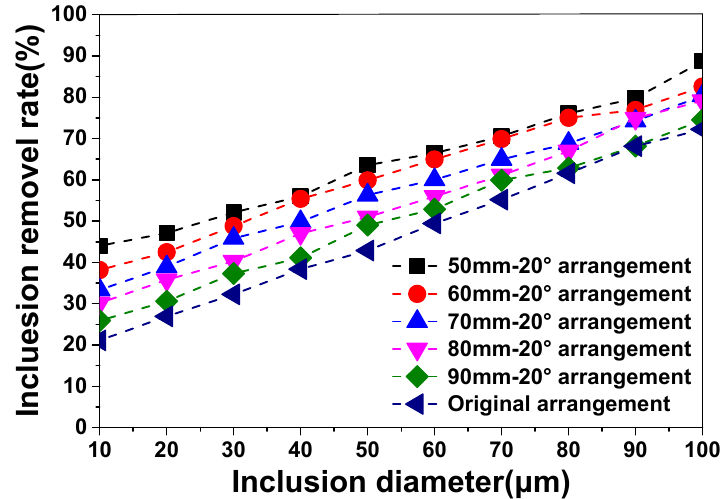
Figure 10. The inclusion removal rate (IRR) distribution for different inclusion sizes.